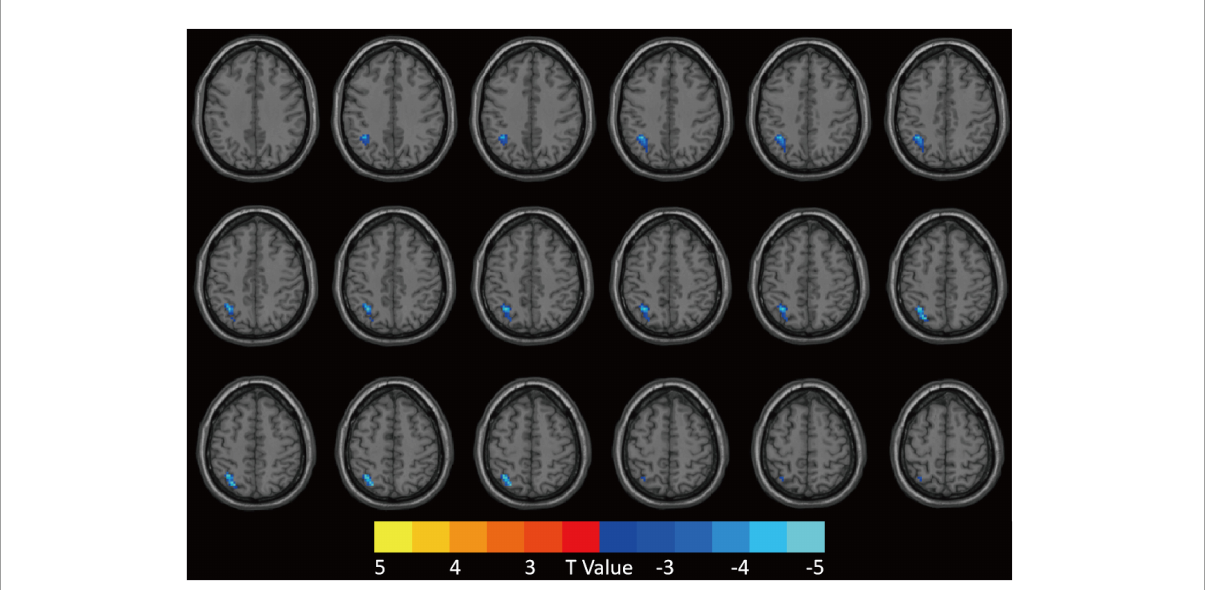
FIGURE2 Patients with CI showed decreased FCS value in the left SPG compared to HCs. GRF was used for multiple comparisons, setting the height threshold at p < 0.005 and the clustering threshold at p < 0.05. CI, chronic insomnia; FCS, functional connectivity strength; SPG, superior parietal gyrus; HCs, healthy controls; GRF, Gaussian random fields.